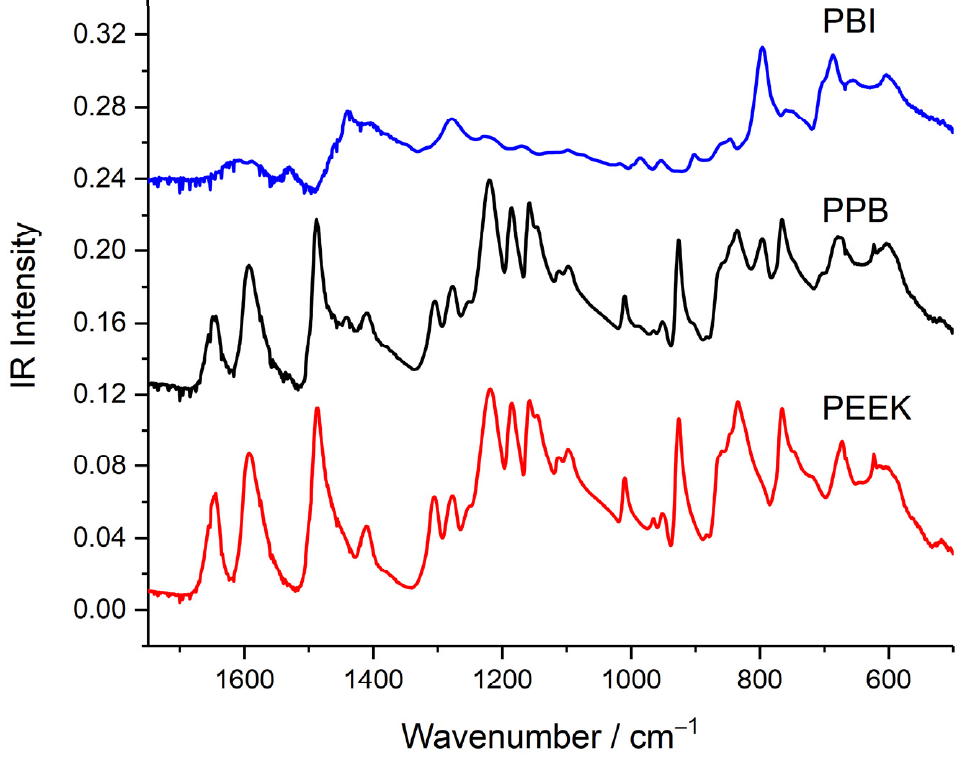
Figure A1. Bulk FTIR spectra of pure PBI and PEEK and their 50:50 blend, PPB, (spectra offset for clarity).